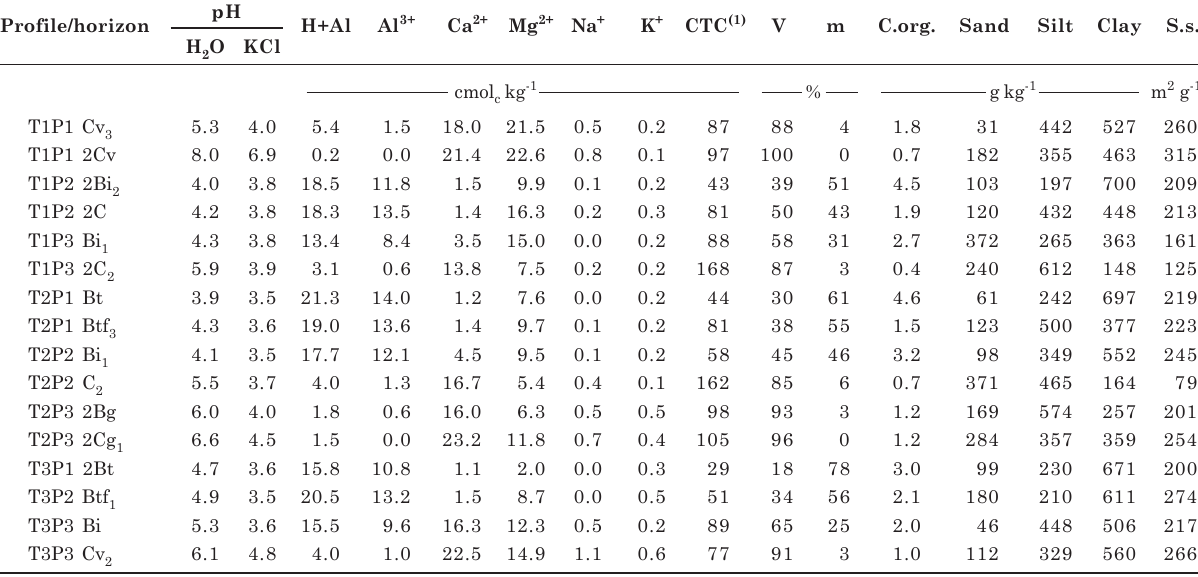
(1) Clay CEC; V: saturation indicator; m: aluminium saturation indicator; C.org.: organic carbon; S.s.: specific